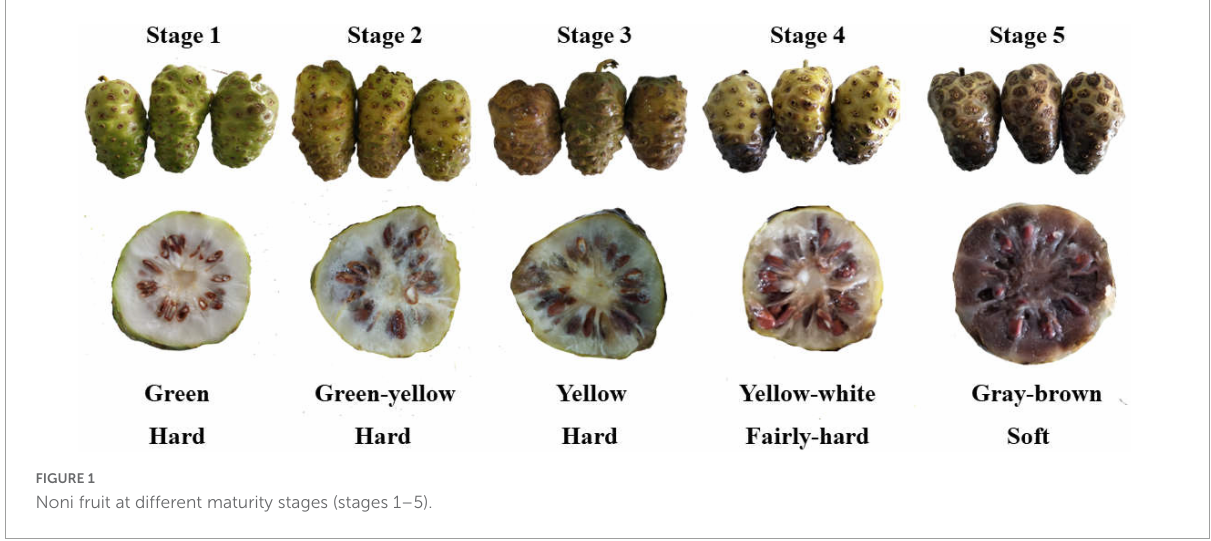
FIGURE1 Noni fruit at different maturity stages (stages 1–5).